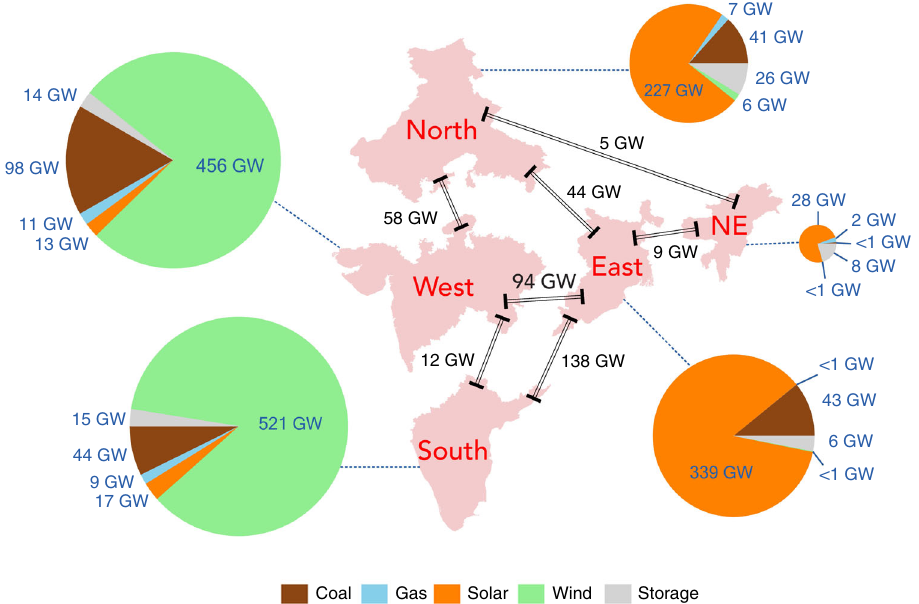
Fig. 2 Regional capacities. Regional distribution of capacities inferred for 2040 using the cost-optimization model applied to the standard 80% renewables scenario. Links between regions indicate capacities identi fi ed for optimal interregional transmission. The size of the pie charts is proportional to the cumulative generation capacities for each region. This fi gure was constructed in MATLAB version 2017b and edited in Adobe InDesign 2020.